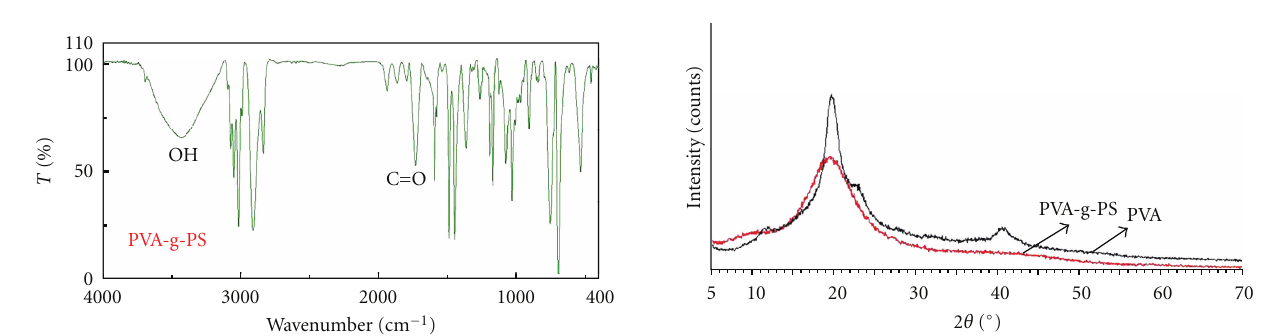
Figure 7: Grafting percent versus [M]/[PVA-RAFT] molarratio.